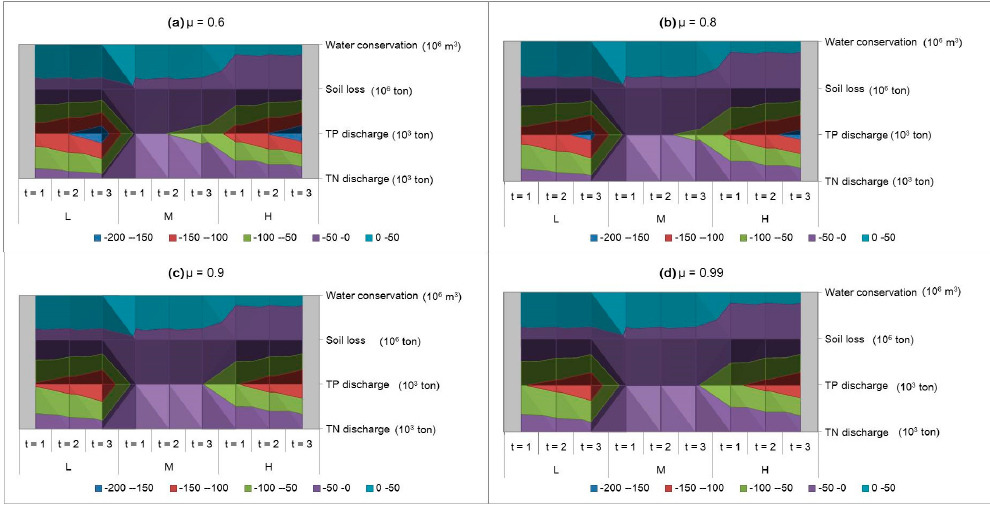
Figure 4. The ecological effects under case 1 when µ levels are varied.